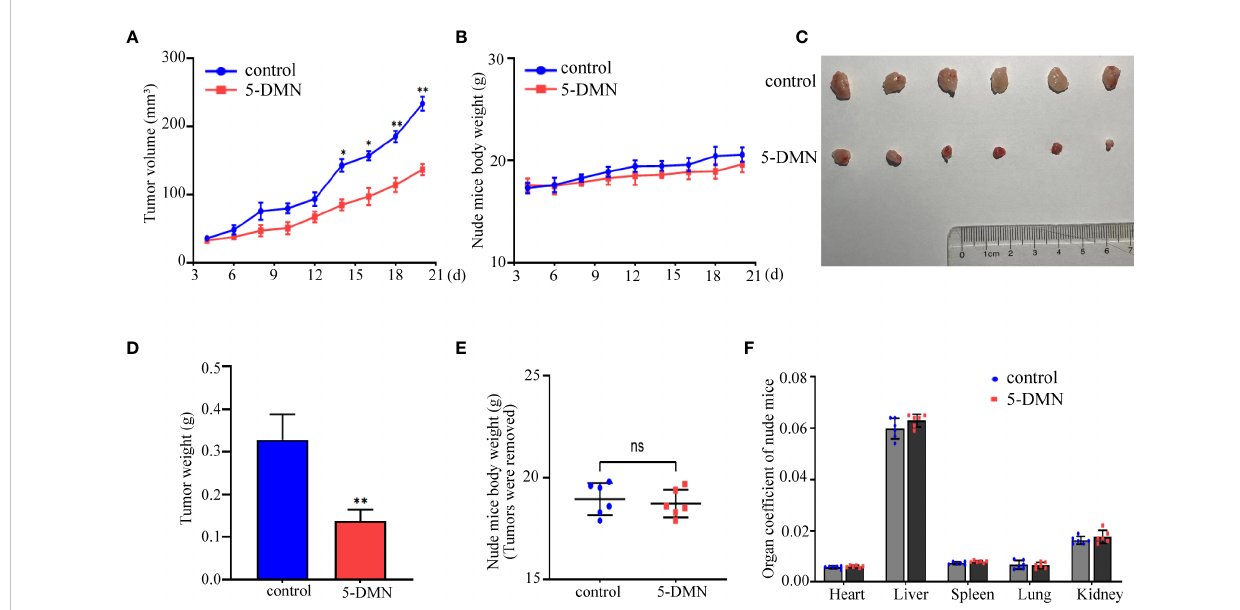
FIGURE 7 The antitumor effect of 5-DMN in BALB/c nude mice tumor model. (A) The volumes of tumor were evaluated at the indicated number of days after animals were treatment with 5-DMN. (B) The body weight changes of 5-DMN-treated group or control group mice. (C) Photograph of tumor tissues isolated from killed nude mice. (D) Quanti fi cation of tumor weight. Body weights (E) and organs weights (F) of nude mice were measured after tumors were resection. *p<0.05, **p<0.01 vs. cells in the untreated group. n= 6. ns, no signi fi